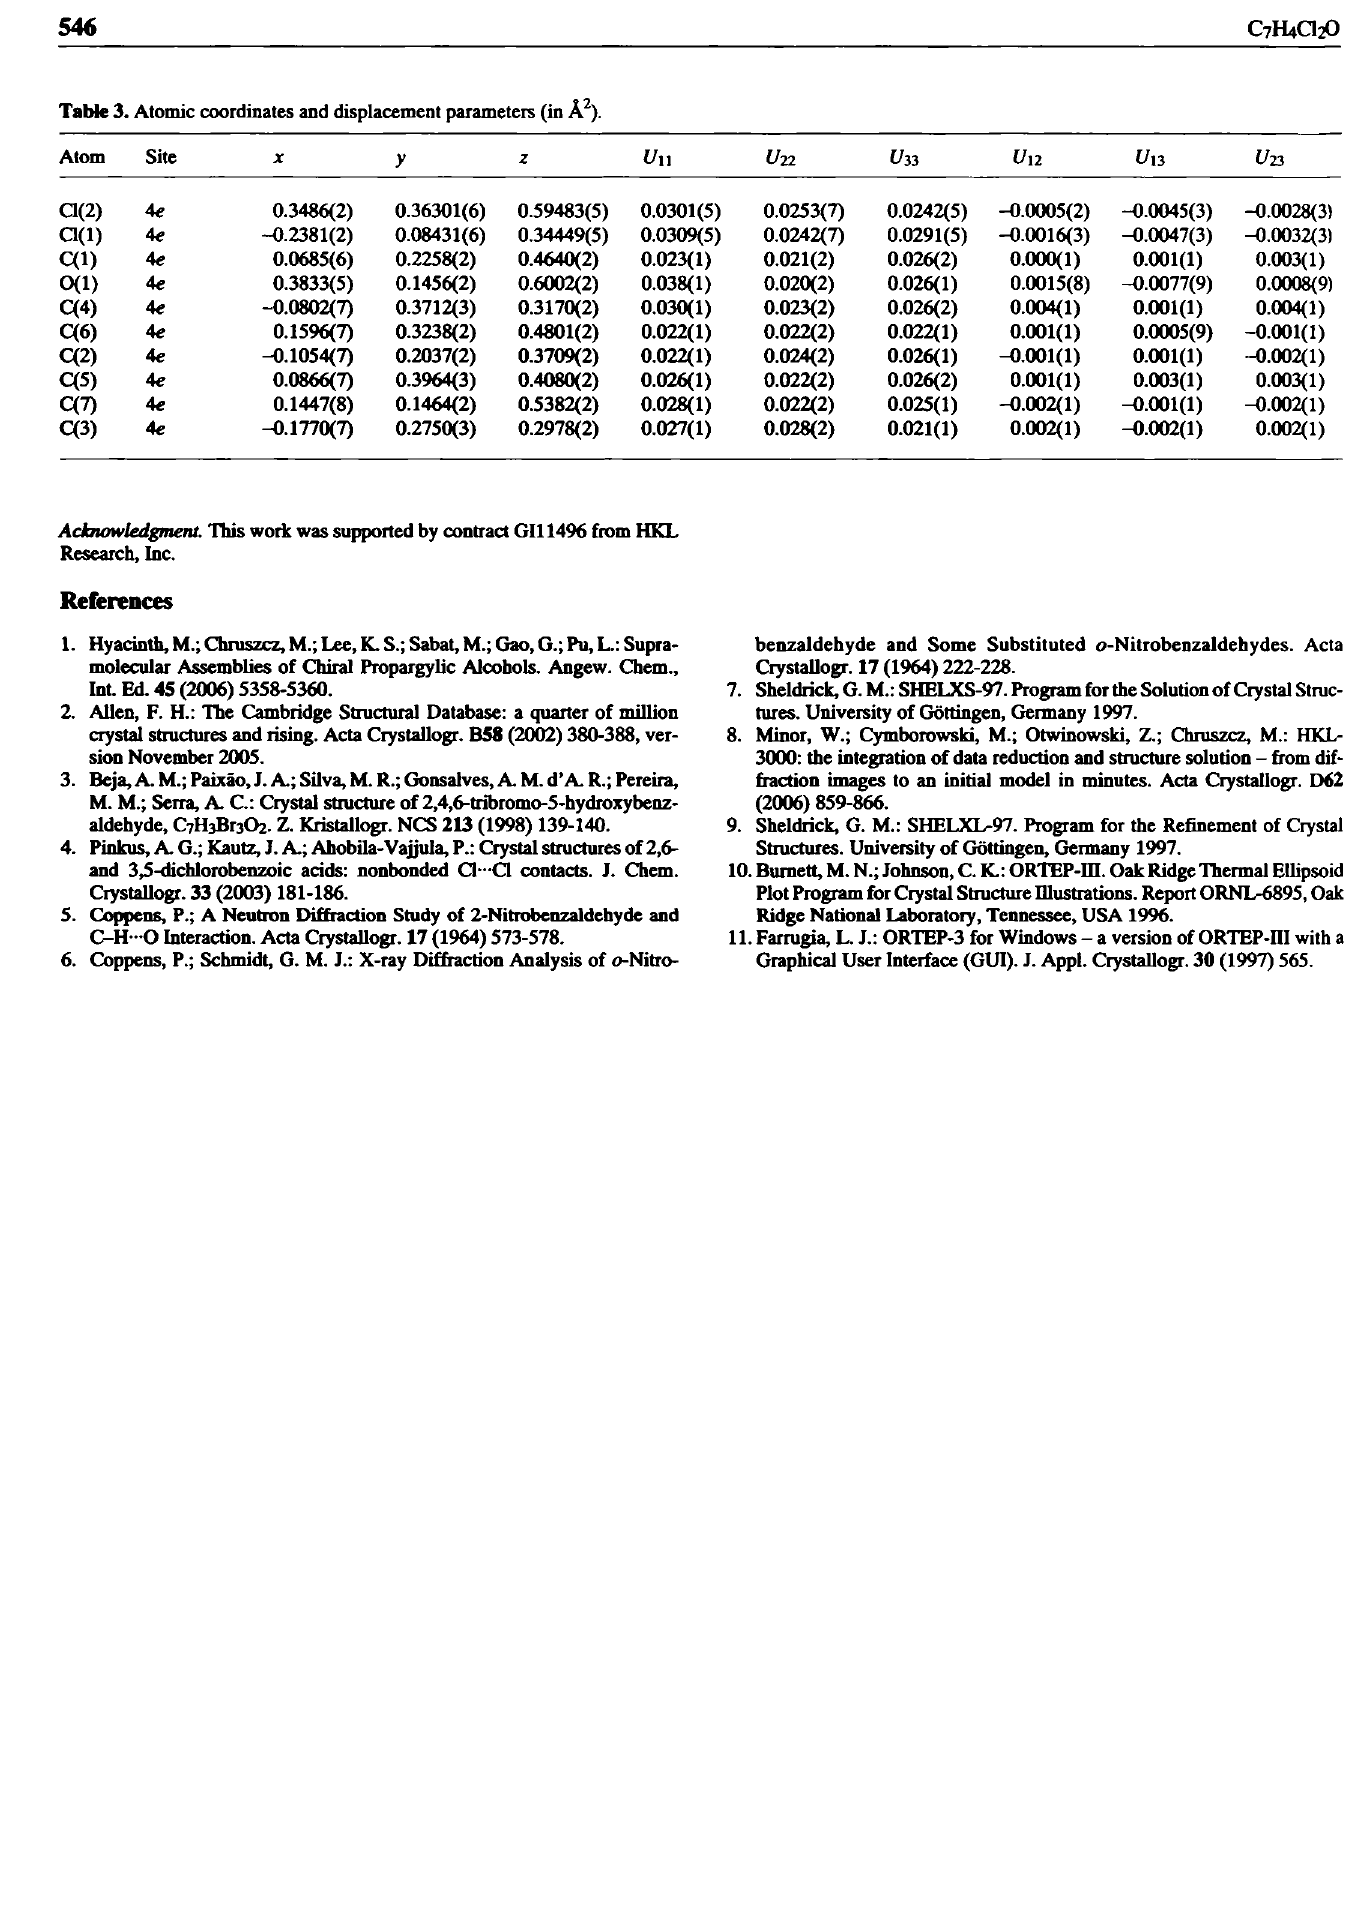
Table 3. Atomic coordinates and displacement parameters (in A 2